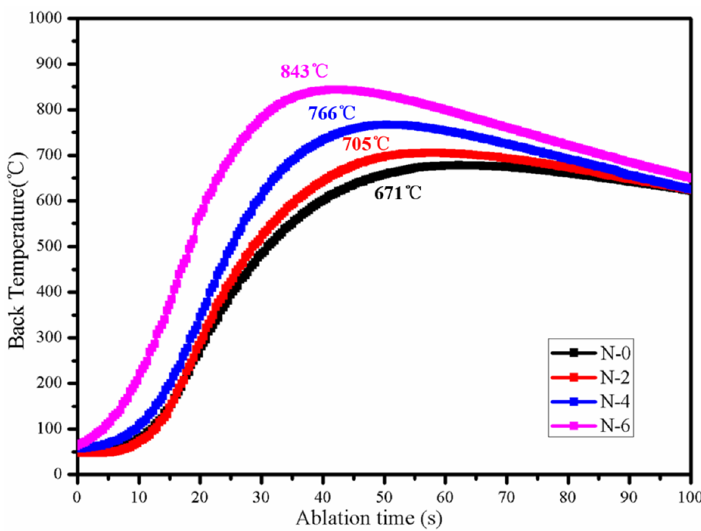
Figure 10. Ablation back temperature curves of NiCoCrAlY/MSZ composite coatings before and after NSS test.